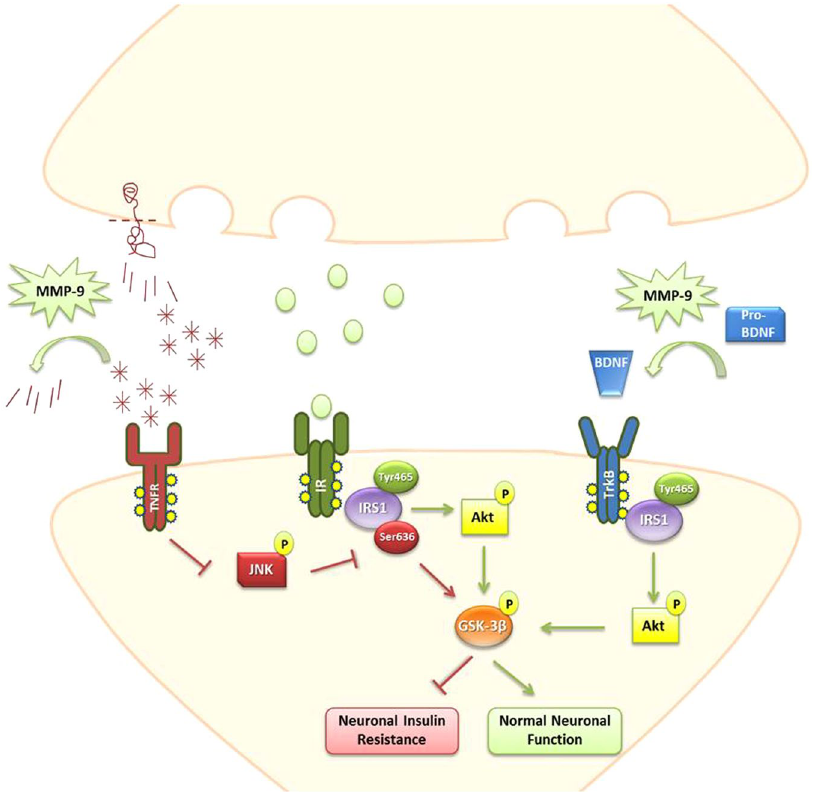
Figure 7. Proposed mechanism of neuroprotective action of MMP-9 in preventing A β -mediated impairment of the insulin survival pathway. A β oligomers generated during early stages of AD stimulate pro-apoptotic pathways, such as TNFR signaling, which activates JNK kinase, resulting in neuronal insulin resistance via IRS1-Ser636 phosphorylation and GSK-3 β activation. MMP-9 protects, in part, by reducing A β amyloid peptide accumulation, thus blocking A β oligomeric-induced defects in insulin signaling. MMP-9 also provides an additional stimulus to insulin, by increasing BDNF levels. The latter binds to the TrkB receptor, inducing IRS1- Tyr465 phosphorylation and Akt activation, hence contributing to normal neuronal